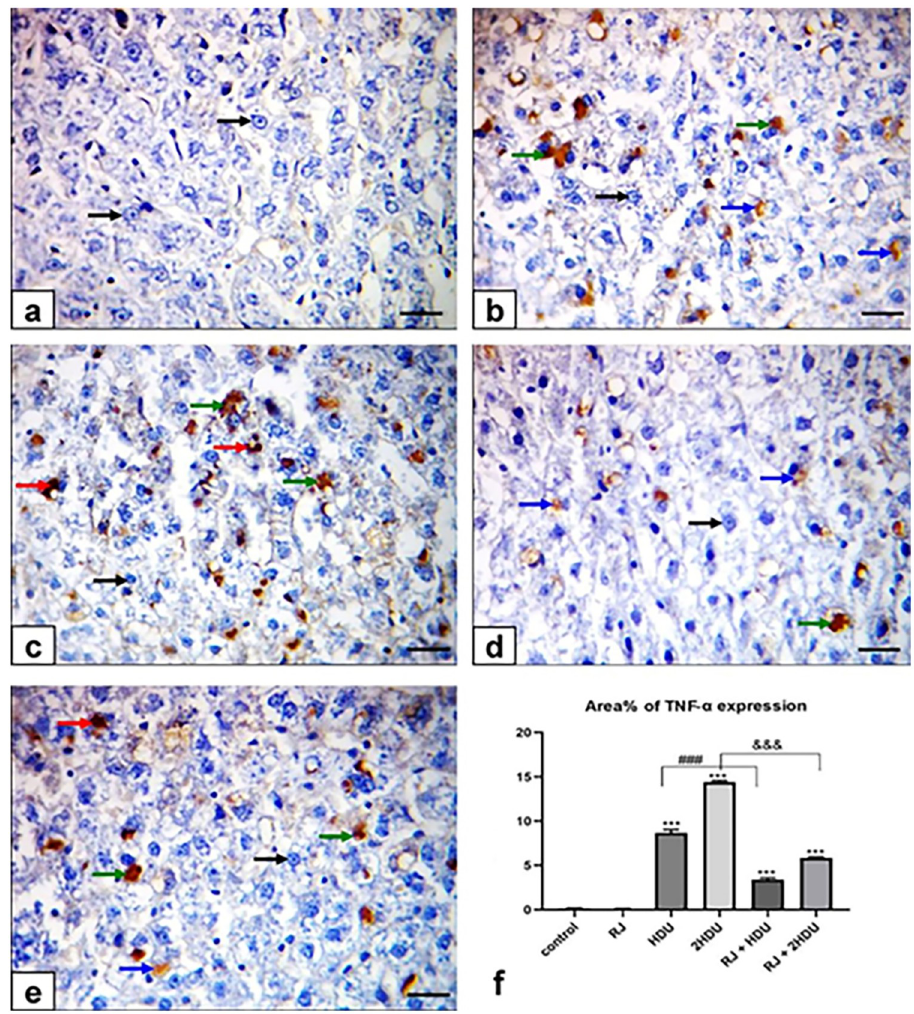
Fig 7. Effects of oral royal jelly (RJ; 100 mg/kg bwt) administration on the pro-inflammatory cytokine (TNF- α ) hepatic expression in rats treated with hydroxyurea (HDU; 225 or 450 mg/kg bwt) for 60 days. Photomicrograph of Immunohistochemical staining of the hepatic TNF- α expression (scale bar = = 50 μ m). (a) control showing negative immunostaining for TNF- α , (b) HDU (225 mg/kg bwt), (c) 2HDU (450 mg/kg bwt), (d) RJ + HDU and (e) RJ + 2HDU showing nuclear TNF- α expression in hepatocytes and Kupffer cells. Negative immunostained hepatocytes (black arrows), strong (red arrows), moderate (green arrows), weak (blue arrows) nuclear TNF- α expression in hepatocytes and Kupffer cells. (f) Alleviating effect RJ on the area (%) of TNF- α positive hepatocytes and Kupffer cells in HDU- intoxicated rats. Data are presented as the mean ± SEM. Compared to the control, significance at (p < 0.01) �� and (p < 0.001) ��� (ANOVA with Dunnett’s multiple comparison test). Compared to HDU treated groups using Unpaired t-test, significance at p < 0.001 ### and &&& for HDU and 2HDU groups, respectively.